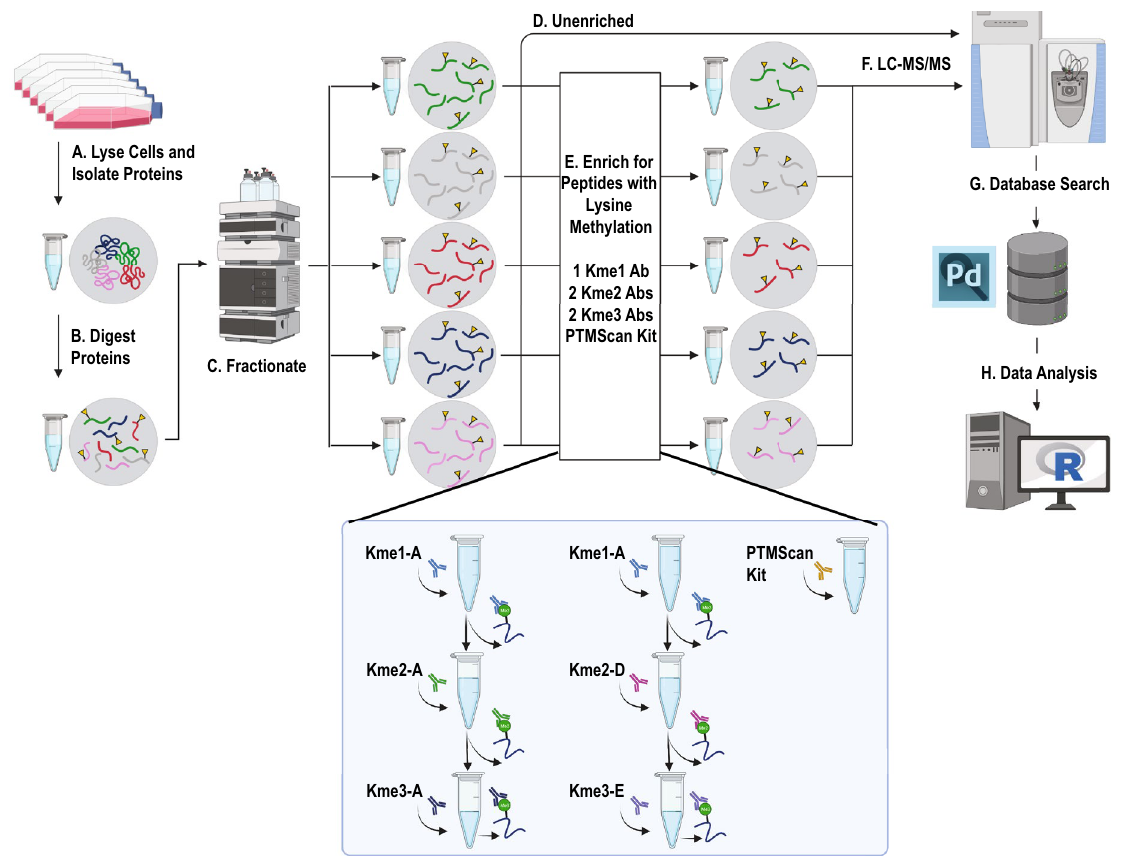
Figure 3. Proteomics workflow for profiling the global lysine methylome from cultured cells. ( a ) Cells are lysed in urea lysis buffer to extract proteins. ( b ) Proteins are denatured and digested to generate peptides. ( c ) Peptides are fractionated offline using high pH reversed-phase chromatography followed by fraction concatenation. ( d ) A portion of each fraction is removed for analysis without enrichment. ( e ) Methylated peptides are enriched using immunoprecipitation with pan-methyllysine antibodies. ( f ) Each enriched and unenriched fraction is analyzed using liquid chromatography-tandem mass spectrometry (LC–MS/MS). ( g ) Database searches are performed to identify peptides and assign modification localization. ( h ) Peptides are filtered for high confidence identification and modification site probability before downstream analysis. Created with